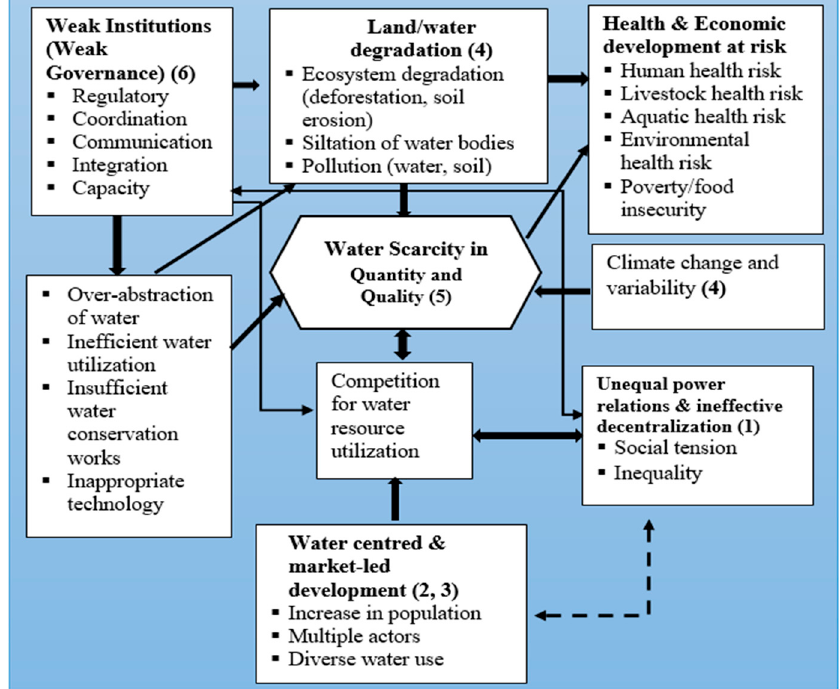
Figure 6. Interrelationships between and reinforced feedback on the dominant water resource management discourses and narratives in the CRV sub-basin. Institutions and governance are linked to all kinds of issues. Note that with the identified problems, the consequences of these interlinked problems would result in water and food insecurity. On the other hand, many of the problems could be solved by improving water and environmental governance. The dotted line indicates an indirect relationship. Numbers in the bracket indicate the major discourses and narratives discussed in detail in the Section 3 (also linked to Figure